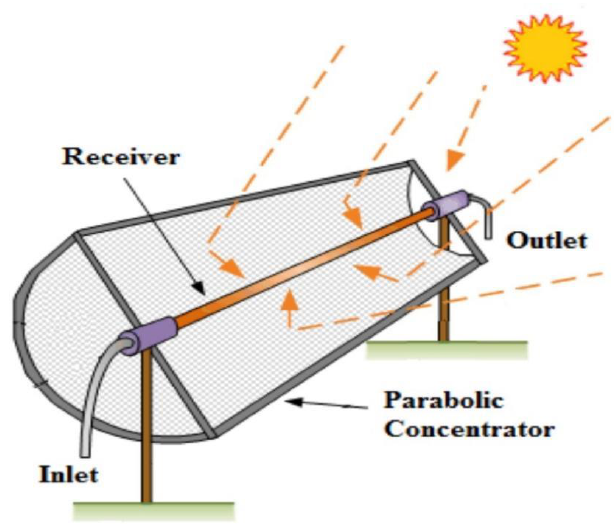
Figure 8. Parabolic trough collector [61].